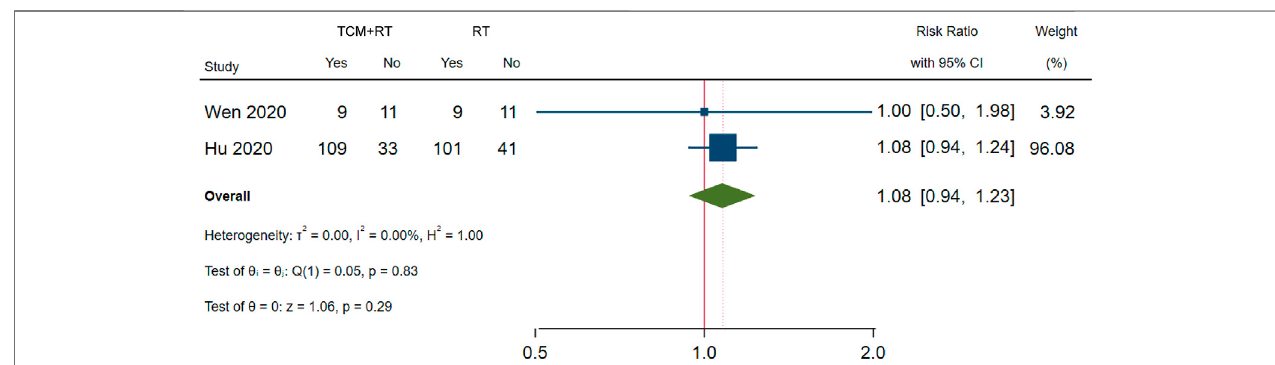
FIGURE 4 | Forest plot of the negativity of the SARS-CoV-2 nucleic acid test.